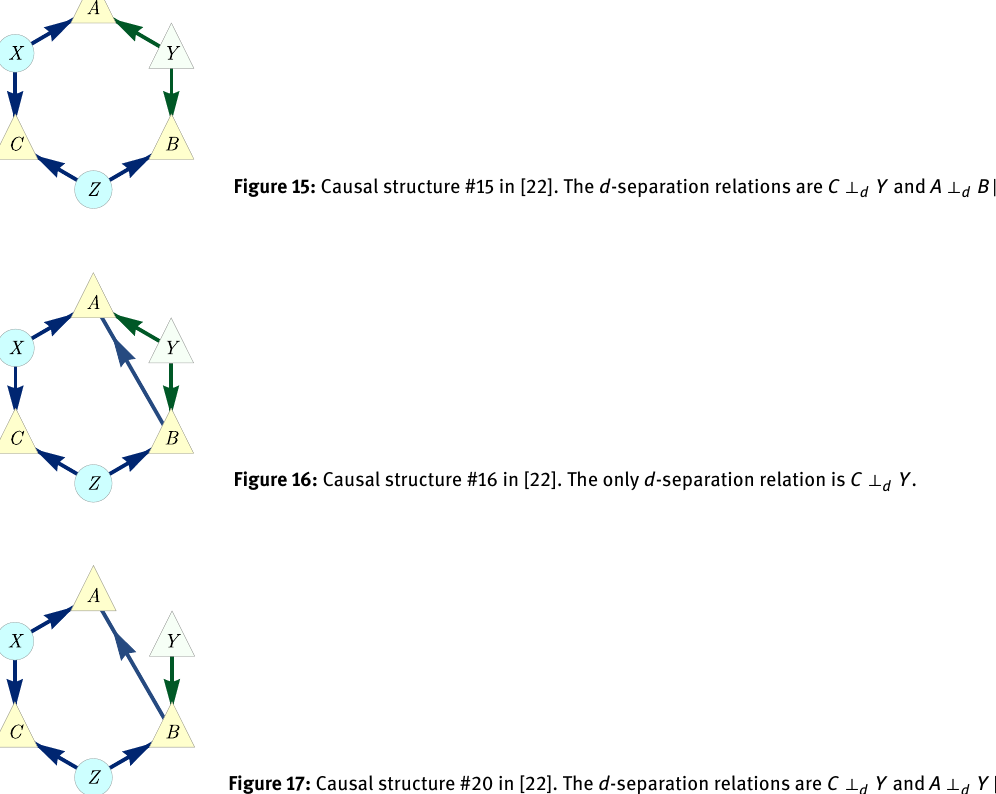
Figure 16: Causal structure #16 in [22]. The only d -separation relation is C ⊥ d Y .